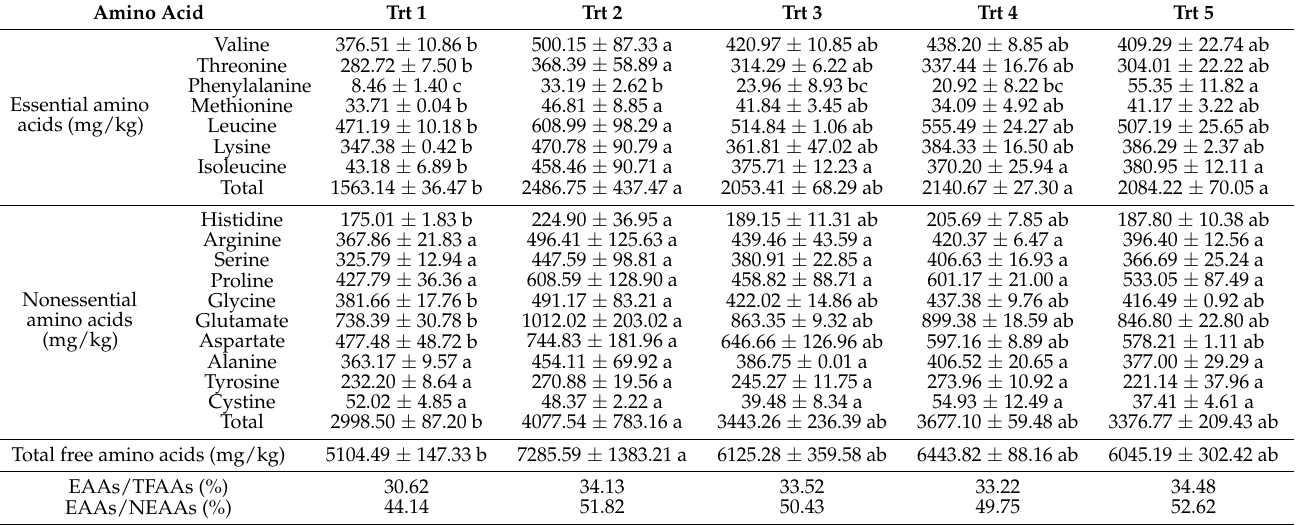
Table 3. Amino acid concentrations in the pericarp of Z. planispinum in different planting